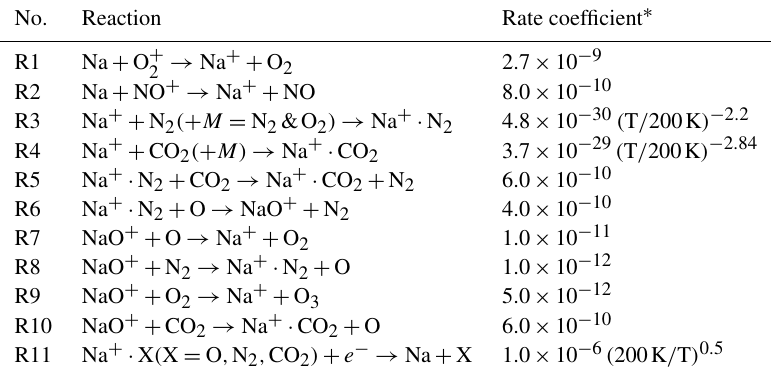
Table 1. Ion–molecule reaction rate coefficients for Na summarized from previous reports (Cox and Plane, 1998; Jiao et al., 2017; Plane et al., 2015, 2004; Yuan et al., 2019).